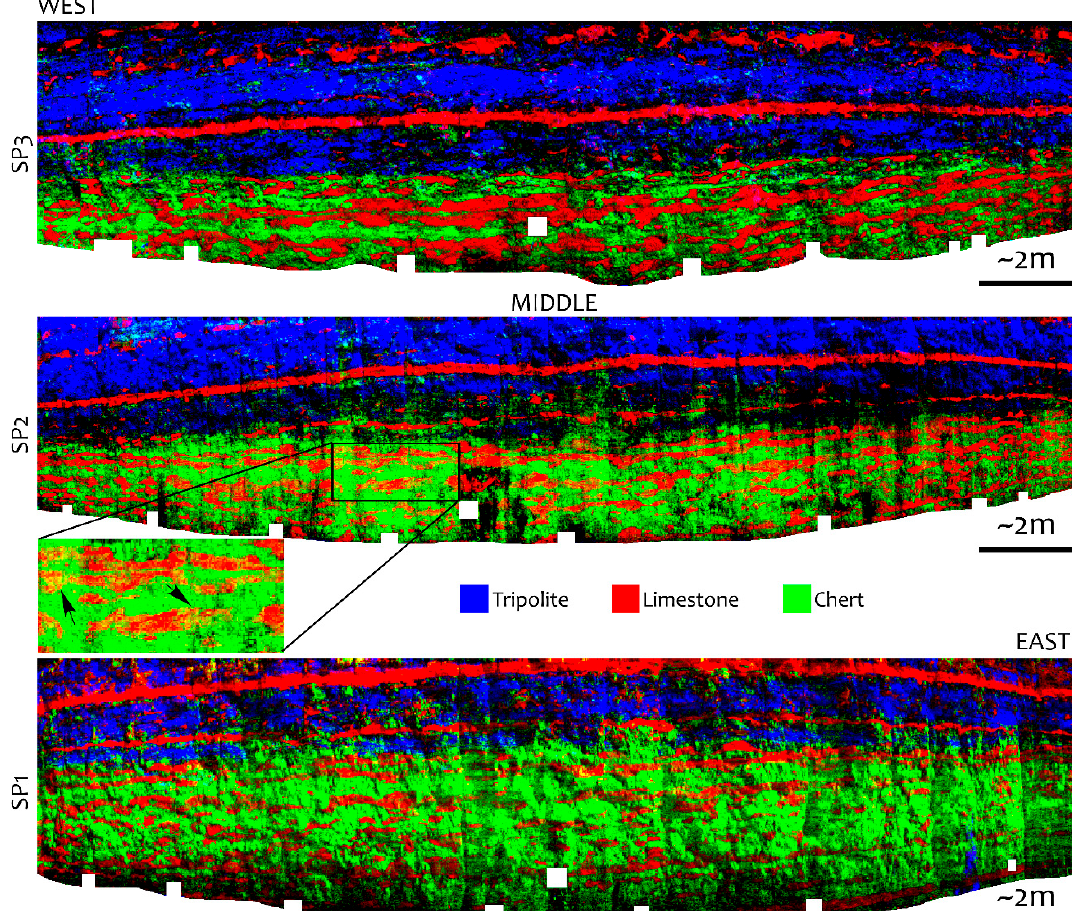
Figure 14. Mixture-tuned match filtering classification results using derived end-member spectra based on spatially coherent MNF components from SP3 to the west to SP1 to the east of the roadcut. The black arrows in the inset image show the areas with similar chert and limestone abundance, characterized by yellow pixels.